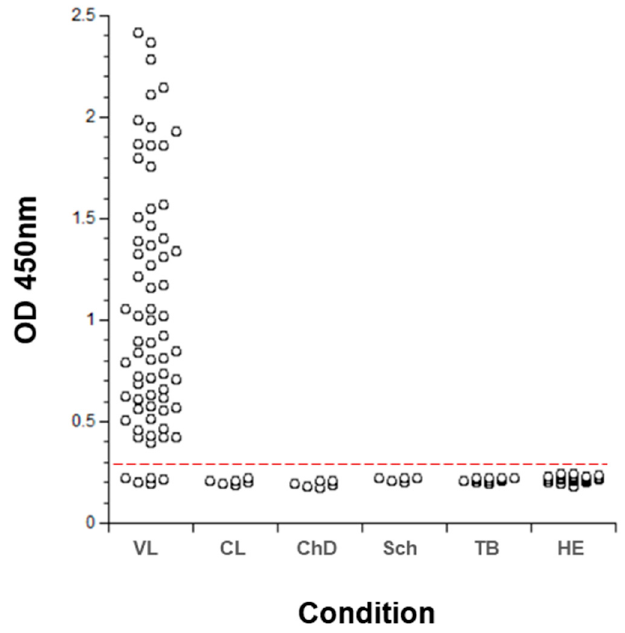
Figure 4. Validation of a new multiplexed assay for the diagnosis of VL. ELISA plates were coated with a pool of mAbs (IgG) specific for all six biomarkers ( Li-isd1, Li-txn1, Li-ntf2, Ld-mao1, Ld-ppi1 and Ld-mad1 ) followed by blocking and overnight incubation with urine samples from VL patients ( n = 69). Patients were from Brazil ( n = 24) and Kenya ( n = 45). Control samples included and urine from non-VL patients with the following diseases: CL (cutaneous leishmaniasis), n = 6; CD (Chagas disease), n = 6; Sch (schistosomiasis), n = 6; and TB (tuberculosis), n = 12. In addition, urine from 35 healthy control subjects (HE) were also included. Plates were washed and wells were incubated with a second pool containing biotinylated mAbs specific for the six leishmanial antigens. Wells were then incubated with streptavidin labeled peroxidase, the substrate H 2 O 2 and the chromophore 3,3 (cid:48) ,5,5 (cid:48) -tetramethylbenzidine (TMB). Optical Density (OD) was then read at 450 nm. The dashed red line represents the cuto ff value (0.257) which was calculated using the average of the OD obtained from the urine of normal healthy control subjects + 3 SD. No di ff erence in the assay sensitivity (93%) between urine samples from VL patients from New World and Old Word VL was observed when the assay was performed separately with these samples (not